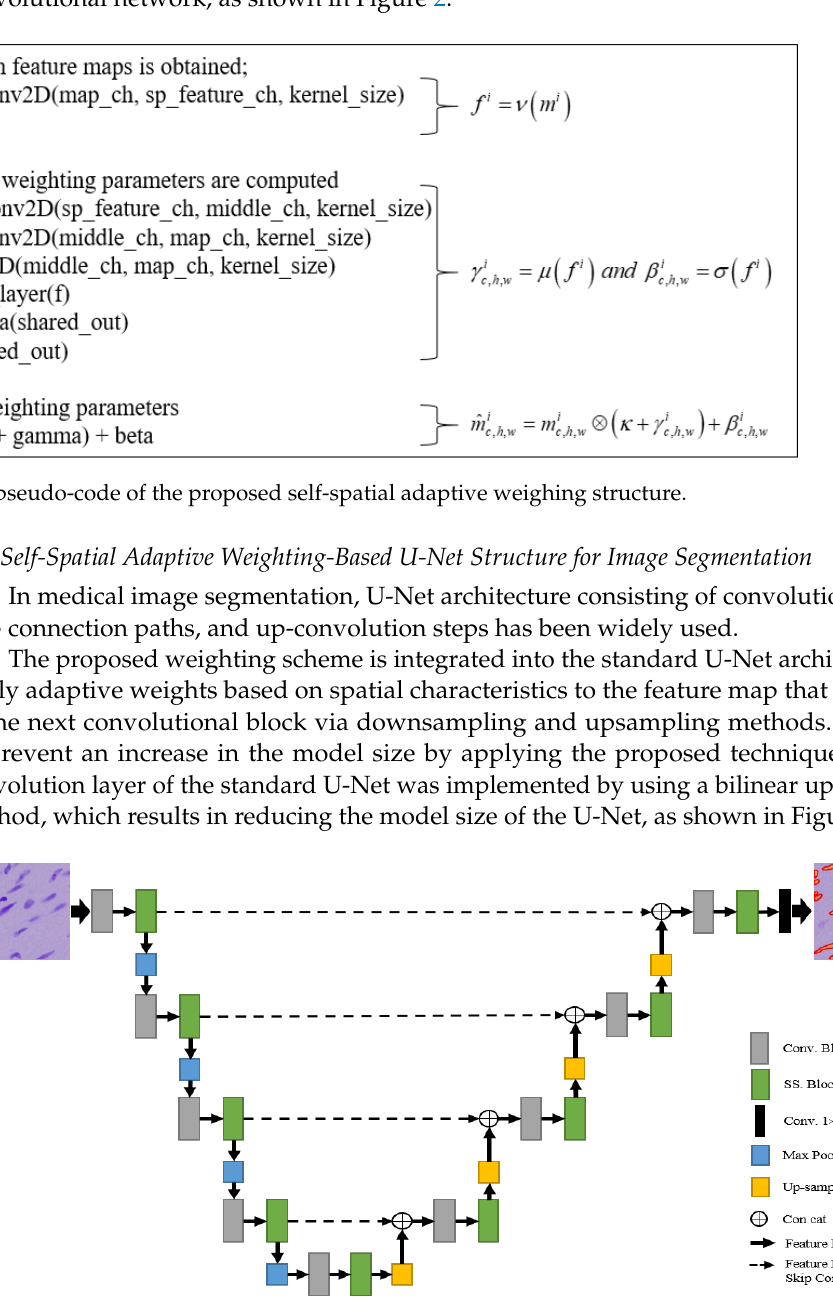
Figure 3. An overall architecture of the proposed self-spatial adaptive weighing-based U-Net (SS-U-Net) for image